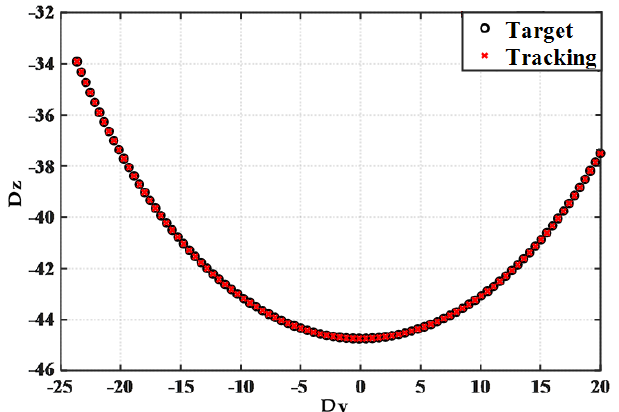
Figure 7. Results of kinematic validation.